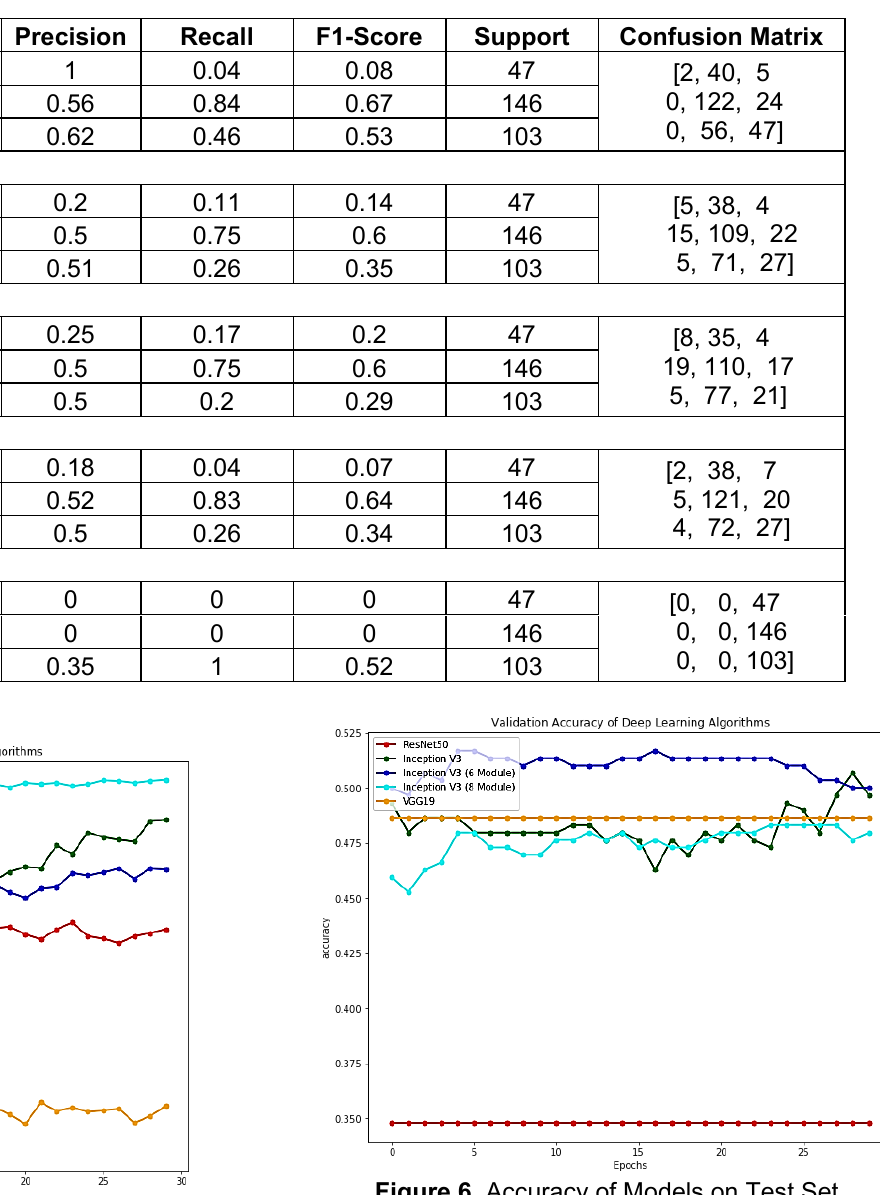
Table 5. Performance of Models